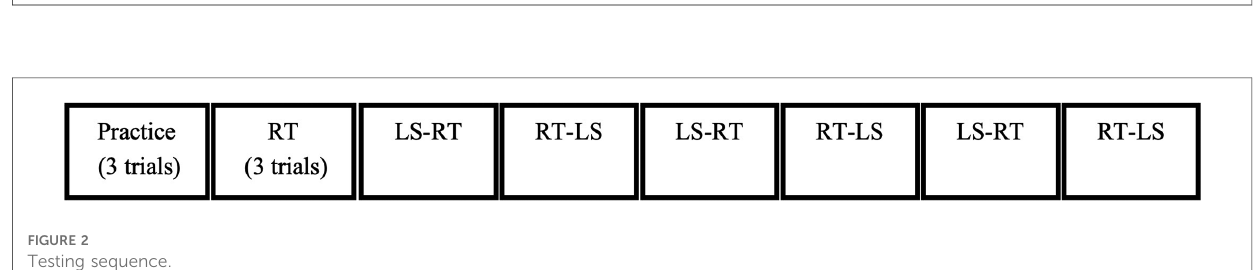
FIGURE 1 Experimental set-up for the UERT task and the dynavision D2 system. The dimension of the light board is shown at the upper left corner. The white solid square indicates the upper left quadrant and dashed square indicates the upper right quadrant used in the UERT task.